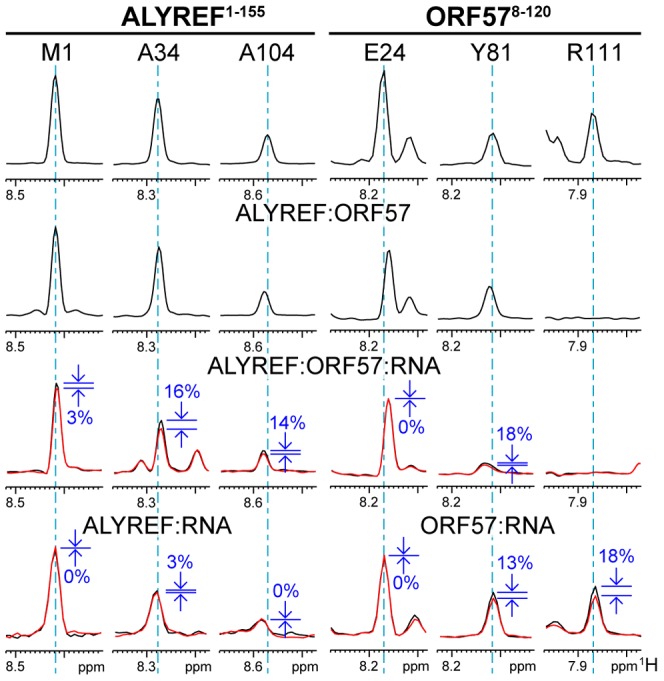
Typical effects of complex formation and RNA→protein ST on selected signals of ALYREF1–155 and ORF578–120.The 1H dimension slices through 1H-15N-correlation spectra are displayed for three representative signals of each protein, on the left for ALYREF and on the right for ORF57. The residue assignments in the free form are labeled at the top, and same signals are shown below each other for different complexes, as indicated. First type of signal (ALYREFM1 and ORF57E24) is not significantly affected by any complex formation, or ST. Second type (ALYREFA34 and ORF57Y81) is not affected much by protein and marginally affected by RNA binding, but is altered or displays significant ST effect in the ternary complex (percentage drop in signal intensity is indicated in blue, and ST spectral traces shown in red). These are residues likely contributing to cooperative ternary complex formation, forming contacts with RNA. Third type of signals originates from the structured regions of proteins (ALYREFA104 and ORF57R111). ALYREFA104 signal is not significantly affected in protein-protein complex, but shows significant increase in ST effect in the ternary complex, suggesting that ORF57 recruits RNA to the proximity of this residue. ORF57R111 signal is broadened beyond detection in protein-protein complex, and remains broadened in the ternary complex. For this signal strong ST effect is observed when in complex with RNA. This residue is involved in initial viral RNA recognition, but then RNA is displaced from this site by ALYREF binding.